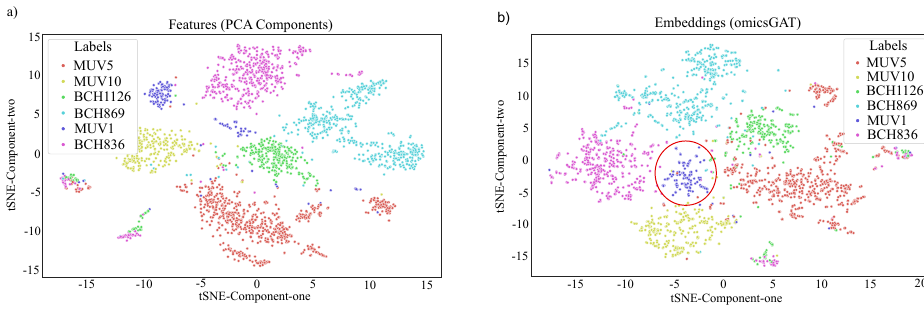
Figure 4. tSNE plots of the ( a ) PCA components generated from the ‘H3K27M-gliomas’ scRNA-seq data and ( b ) omicsGAT-generated embeddings for cell